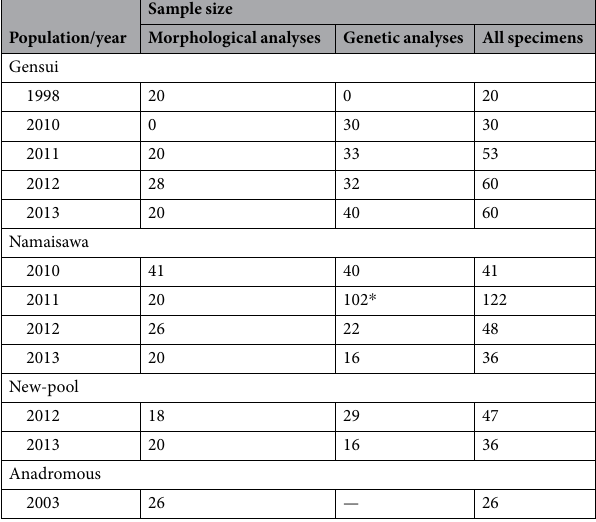
Morphological measurements. We used 233 adult sticklebacks (range: 18–41 for each group) for the mor- phological analyses (Table 2), and their standard lengths ranged from 45.49–67.12 mm in 1998, 40.14–64.48 mm in 2011, 38.42–70.78 mm in 2012, and 49.35–66.75 mm in 2013 for the Gensui population; 41.92–79.69 mm in